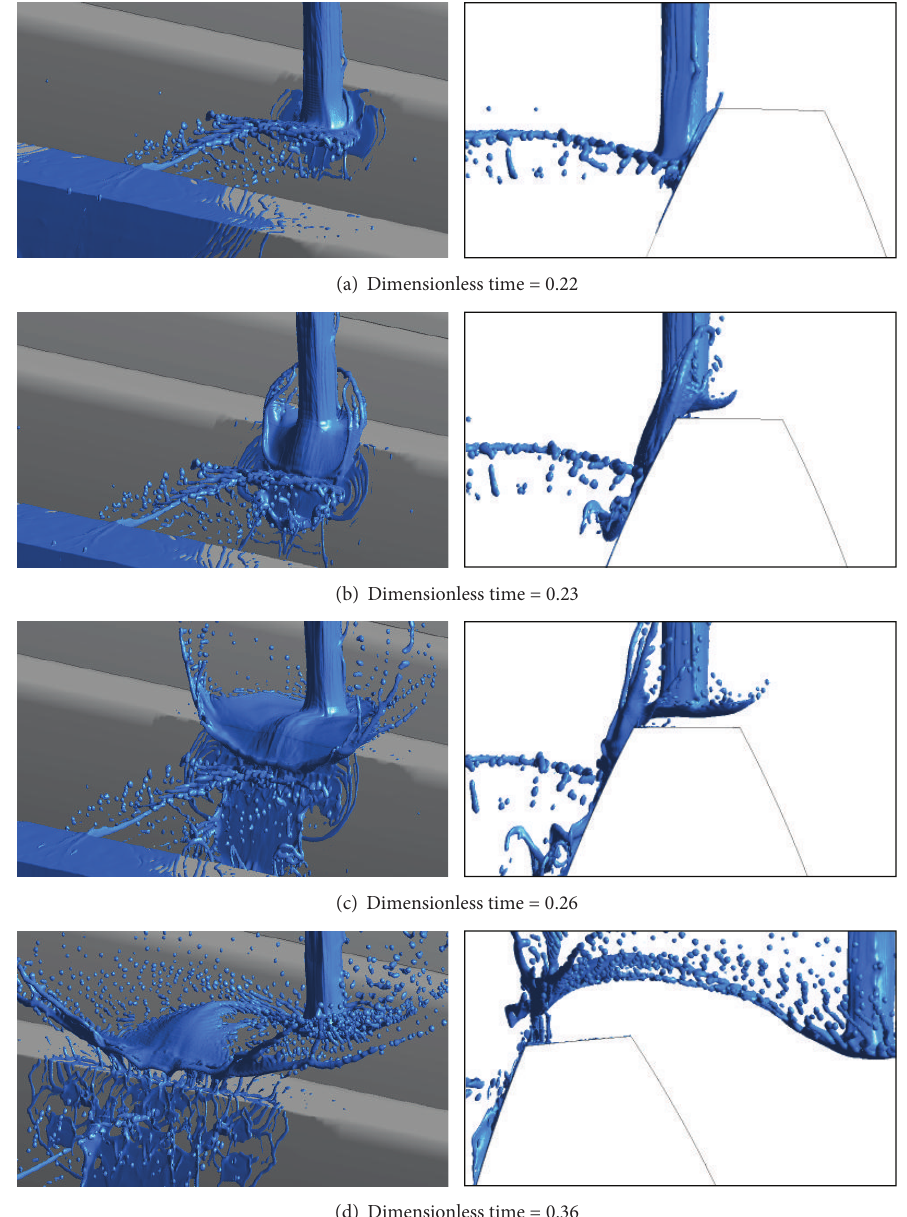
Figure 19: Run 3D-2: isosurface of oil volume fraction =